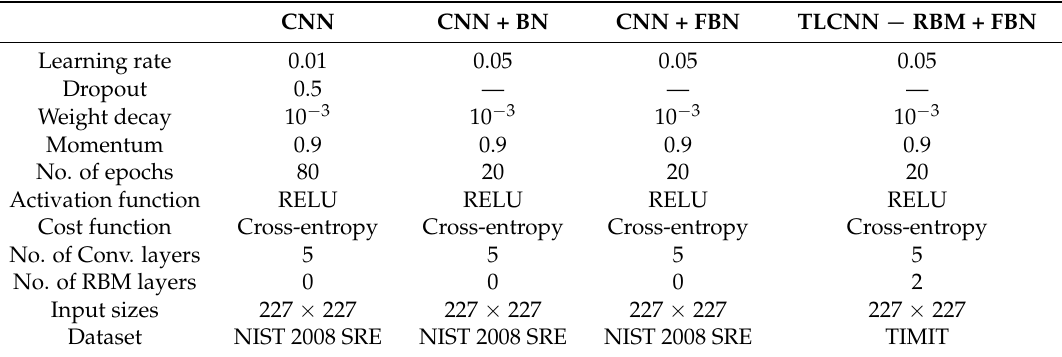
Table 1. Proposed network architectures and